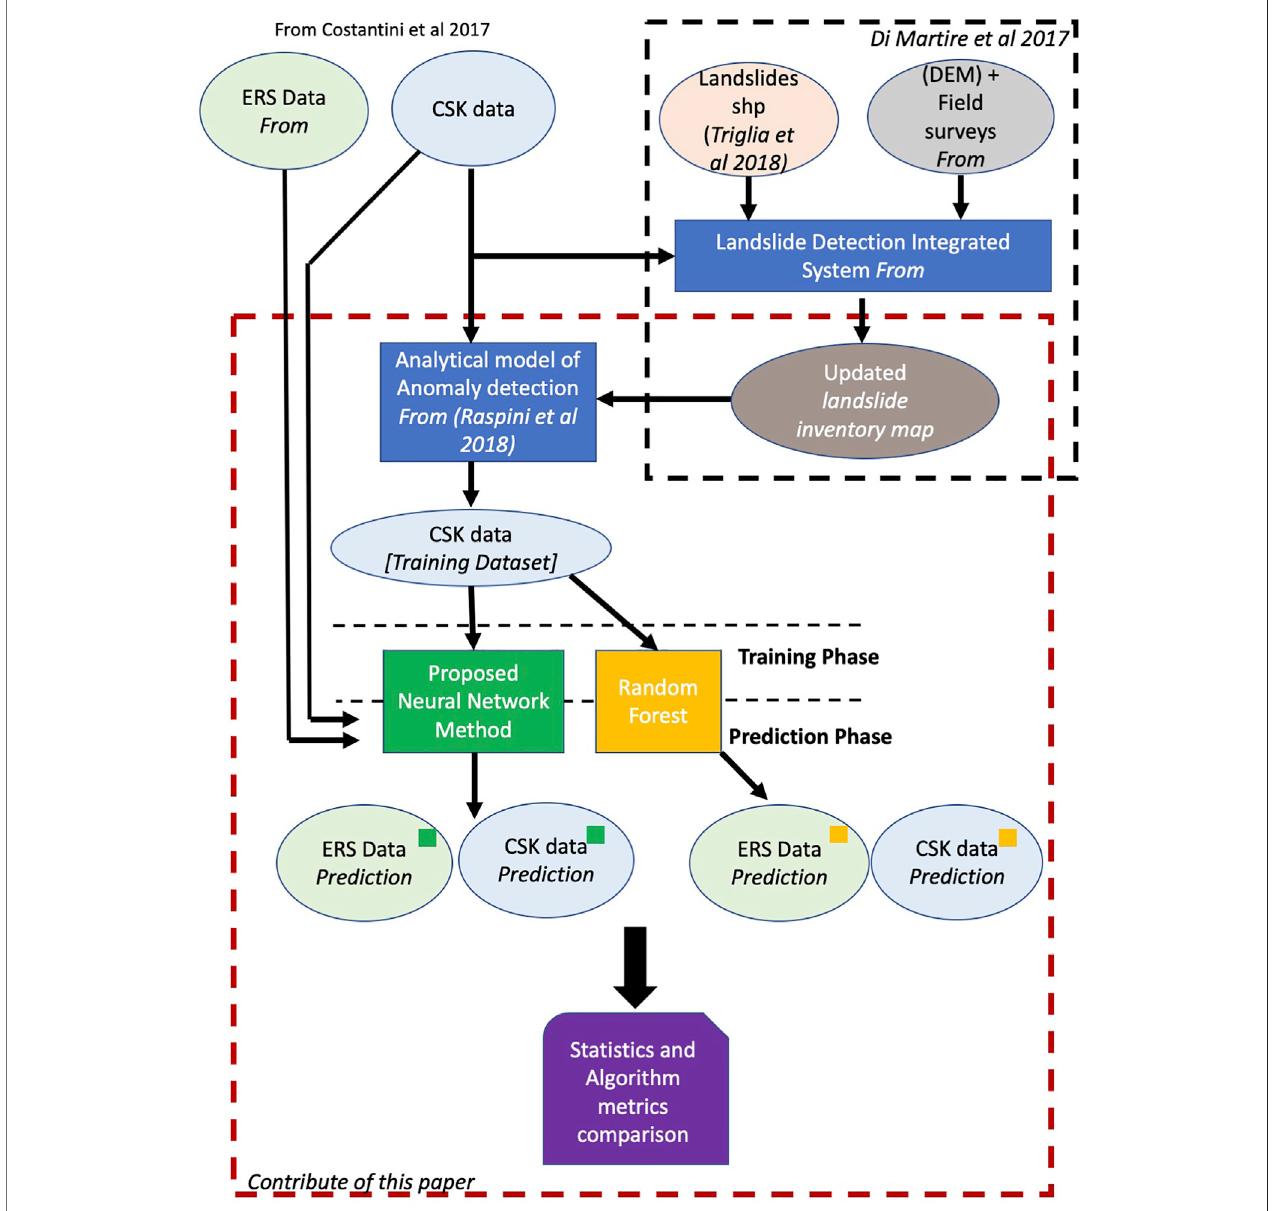
FIGURE 1 | Data Processing work fl ow scheme adopted in this study. The contribution of reference (Di Martire et al., 2017) is highlighted as a black dashed line, whereas the contribution of this paper is highlighted by a red dashed line. Our Training dataset is formed by anomalous points [as described in (Raspini et al., 2018)] belongingtotheCSKdatasetfalling withinalandslideareaextractedfromthelandslideinventory mapdescribedinDiMartire etal.(2017).Thesepoints arethenused to train the Neural network and the Random Forset classi fi ers, which are then applied to the entire dataset.